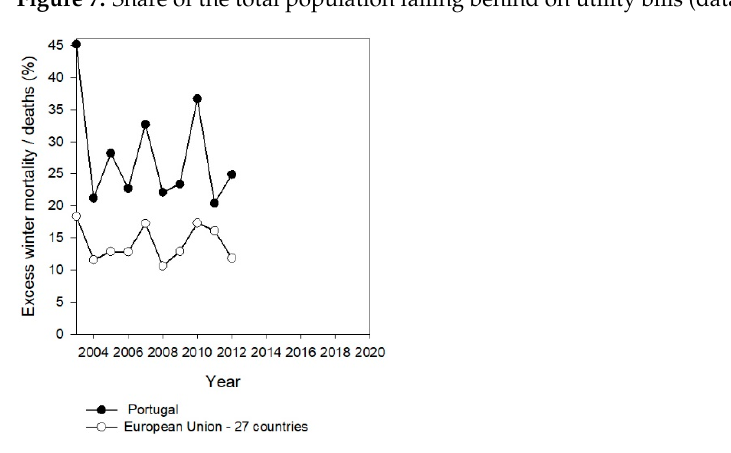
Figure 8. Share of excess winter mortality/deaths (data source [14]).